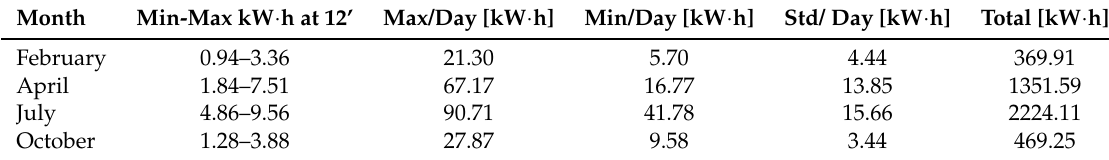
Table 1. Statistical features of predicted energy production during selected months.